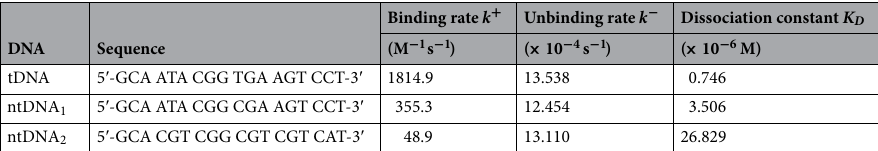
Table 1. Kinetic constants of DNA hybridisation measured by MC receiver.